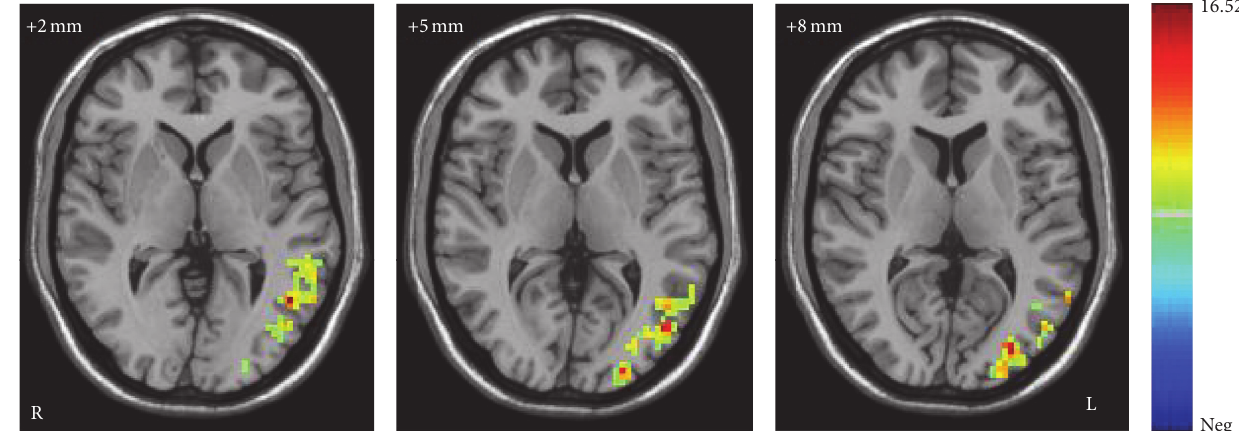
Figure 1: The main effect of diagnostic groups on ALFF in the MDD and HC. The axial images (MNI coordinate 𝑧 = +2mm, +5 mm, and +8mm) display the regions in the left middle temporal gyrus and left occipital cortex that show increased ALFF in patients with major depressive disorder (MDD), compared to healthy controls (HC) at rest ( 𝑃 < 0.05 by AlphaSim correction, and 123 voxels minimum). Color bar represents the range of 𝐹 values.